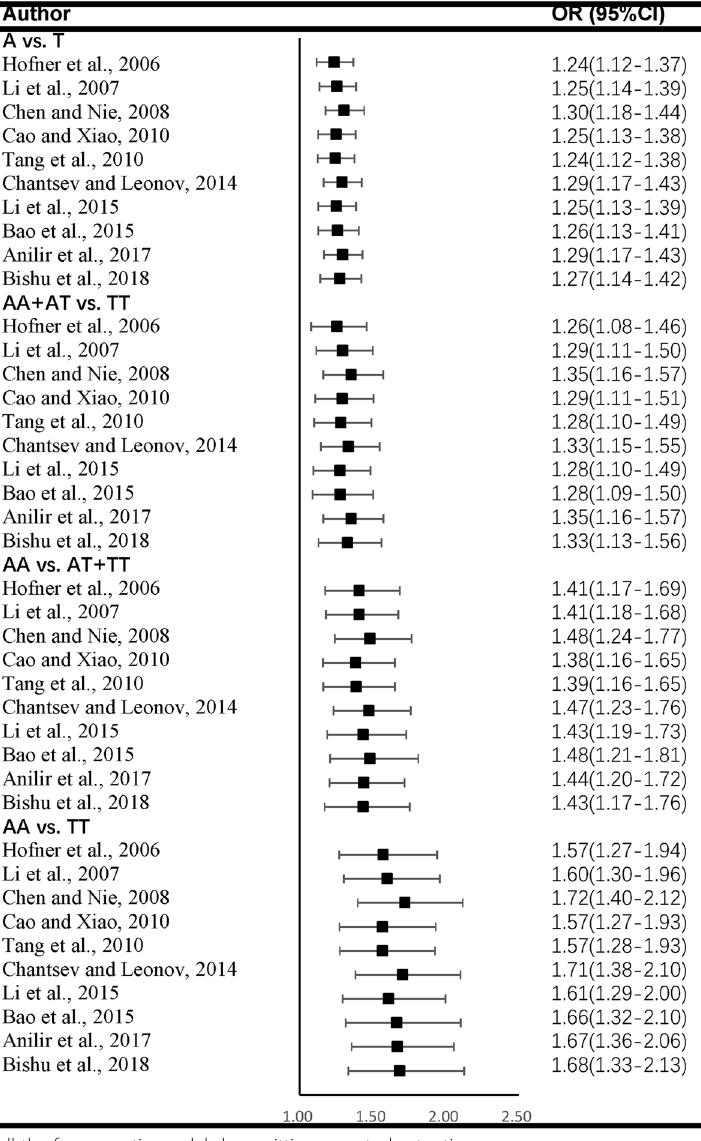
Fig. 4 Sensitivity analyses of all the four genetic models by omitting one study at a